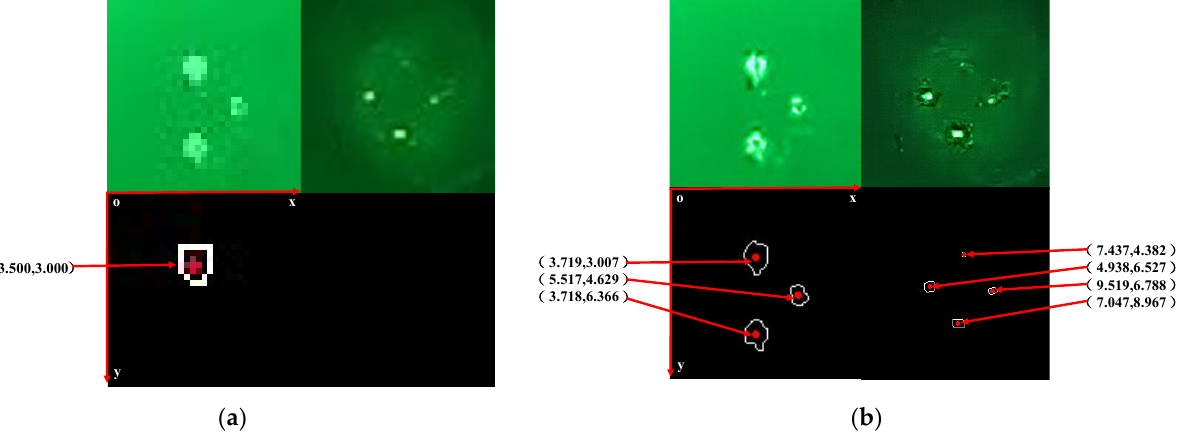
Figure 16. Comparison between the traditional algorithm and the subpixel centroid localization method based on SRGAN and Zernike moments (the top-row images are targets, and the bottom-row images are results): ( a ) Results of OTSU threshold segmentation + Zernike moment sub-pixel center search; ( b ) Results of our method.